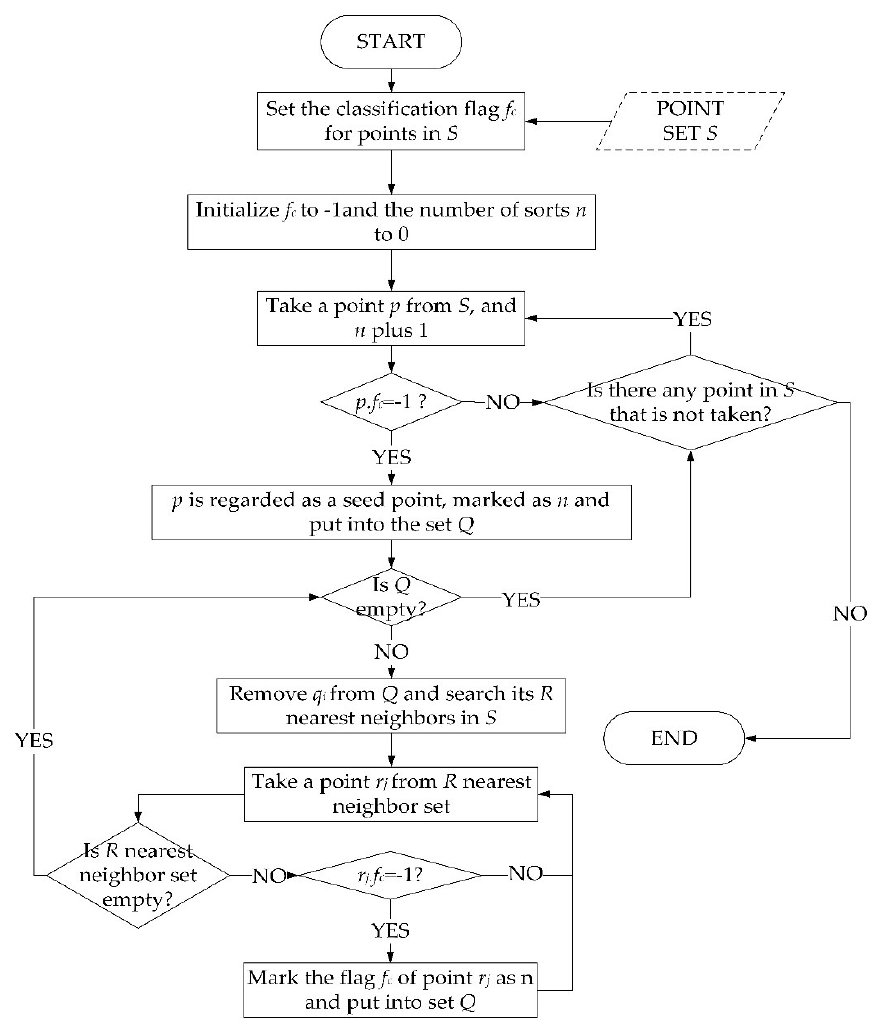
Figure 5. Flowchart of patch classification.